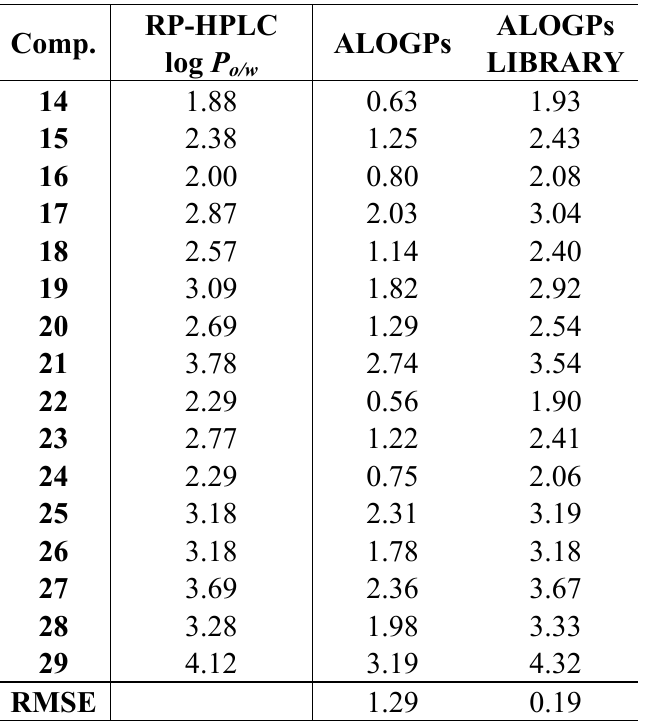
Table 4. Calculated log P for quinoxaline derivatives using ALOGPS with and without o/w LIBRARY